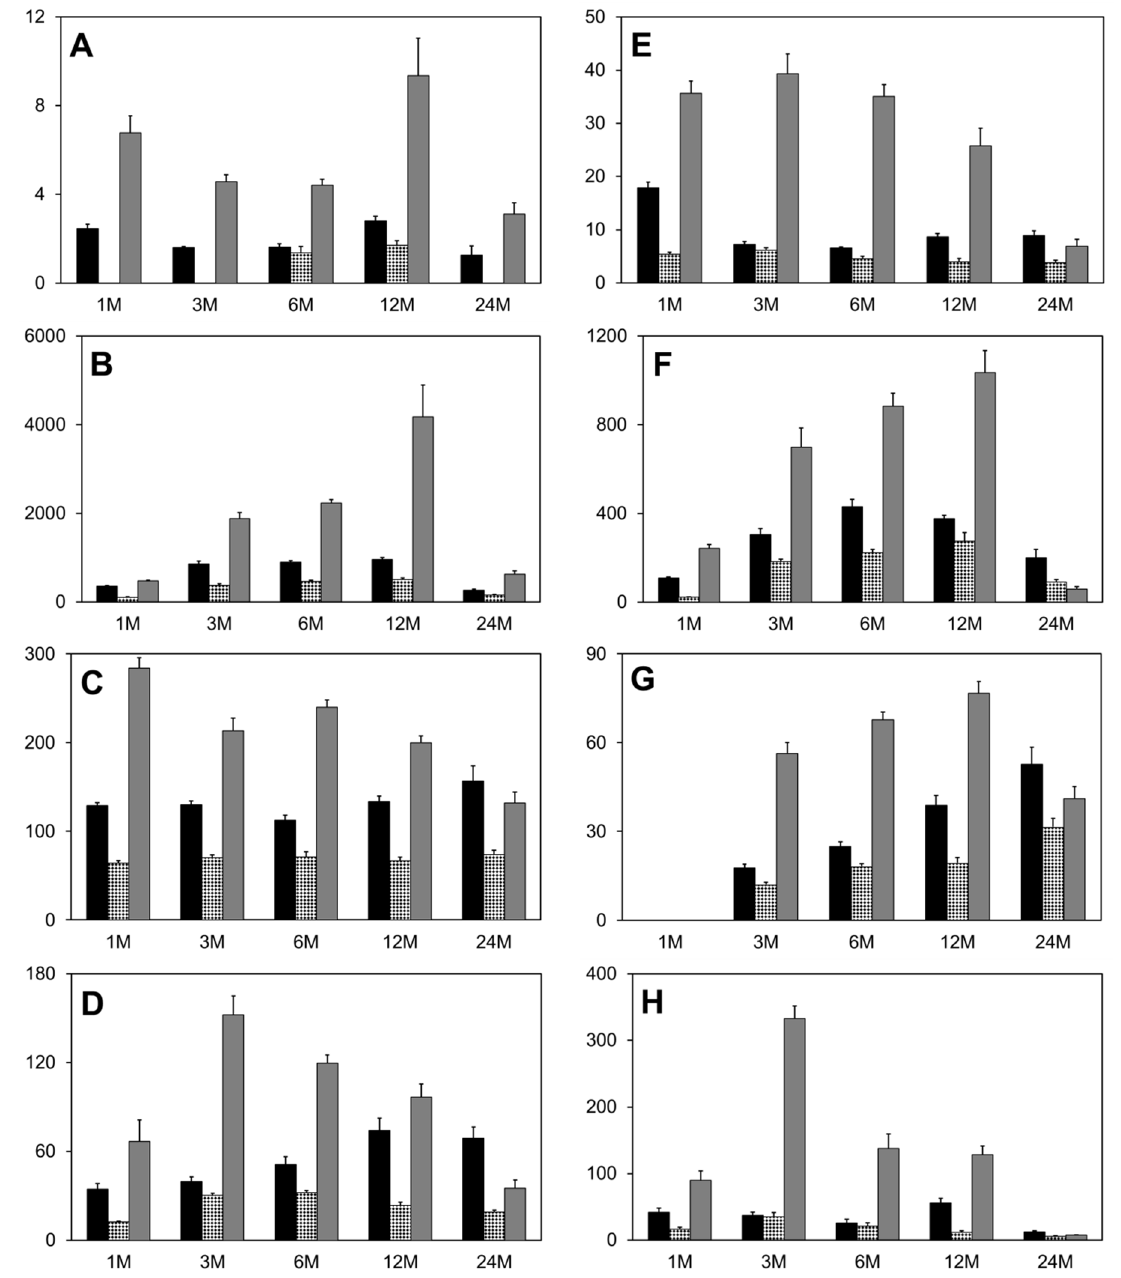
Figure 5. Tissue tungsten concentrations. ( A ) brain; ( B ) femur; ( C ) kidney; ( D ) liver; ( E ) serum; ( F ) spleen; ( G ) testes; ( H ) urine. The y-axis represents ng W/gm tissue, except for (E) (ng W/mL serum) and (H) (µg W/mg creatinine). Black bar, WTa group; stippled bar, WNiTa group; gray bar, WCoTa group. Data are the mean of 10 independent measurements. Error bars represent the standard error of the